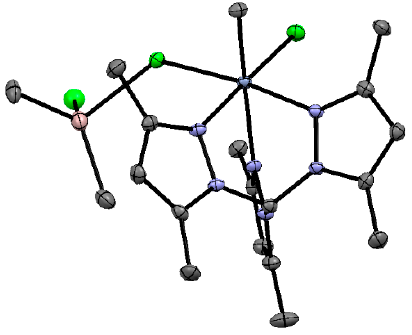
Figure 36. Molecular structure of complex Cr19 [254].